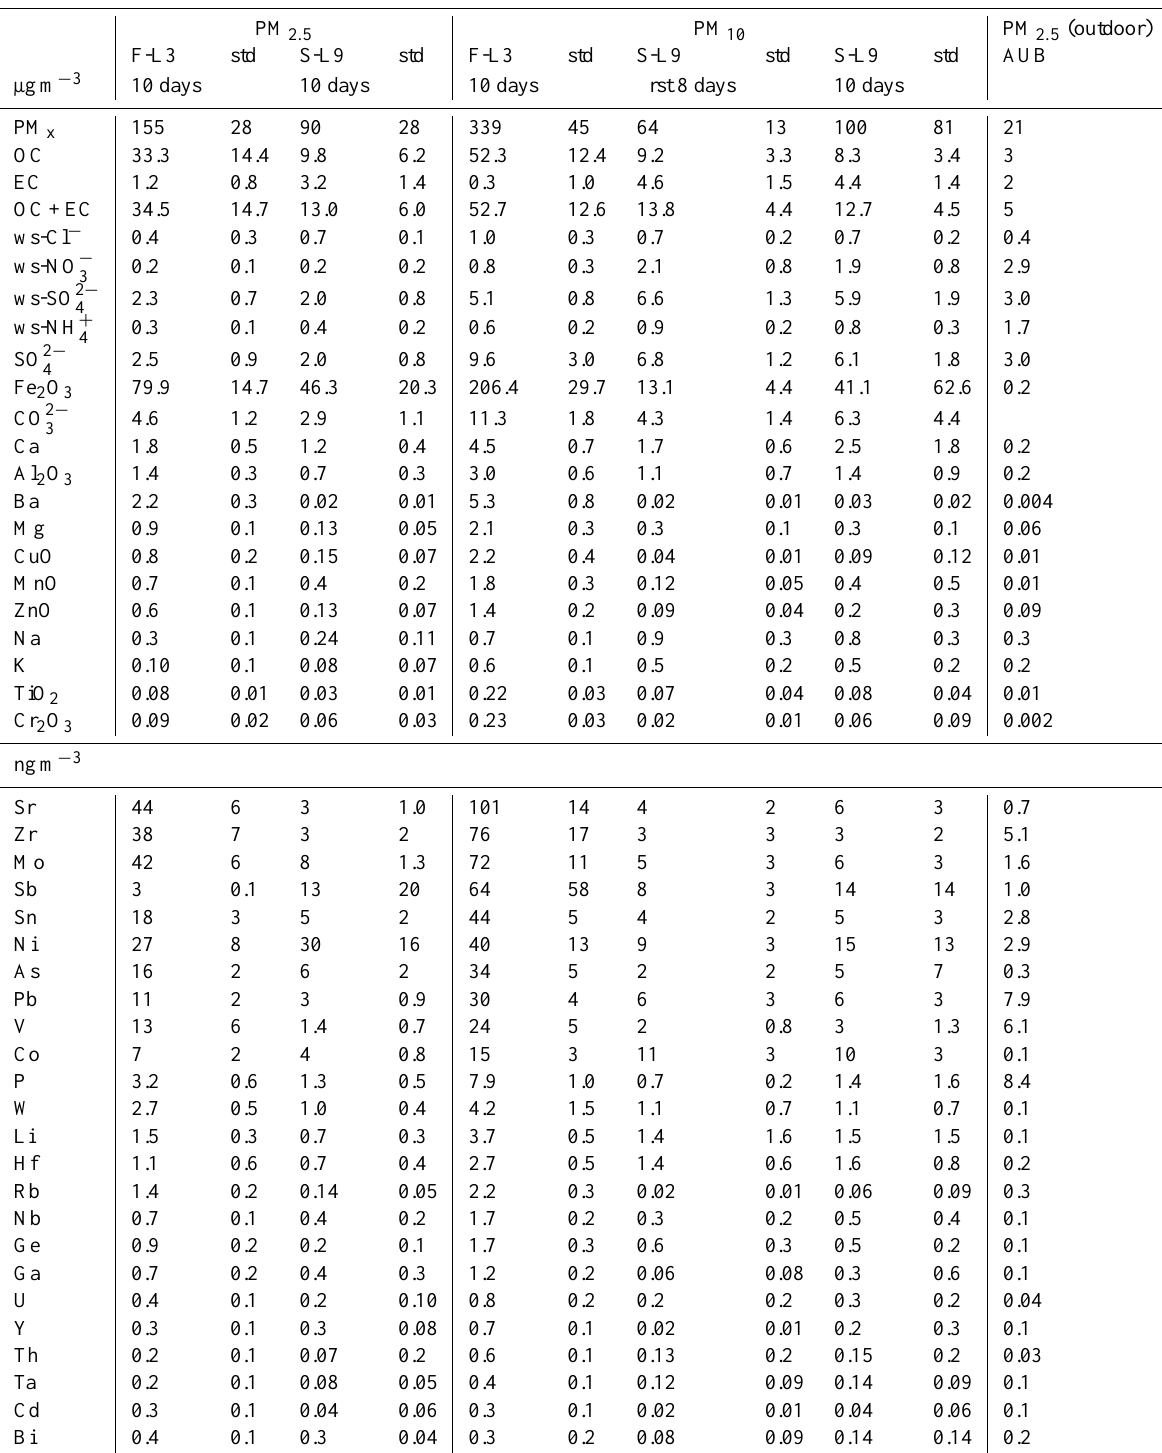
Table 4. Mean levels and standard deviation (std) of PM, and analyzed components in PM 10 and PM 2 . 5 at Fontana (L3) and Sagrera (L9) platform sites from 5 to 24 July 2011. ws, water soluble; SIA, secondary inorganic aerosols. Annual urban background (AUB) levels of PM 2 . 5 components reported for Barcelona by P´erez et al. (2008) are also shown for